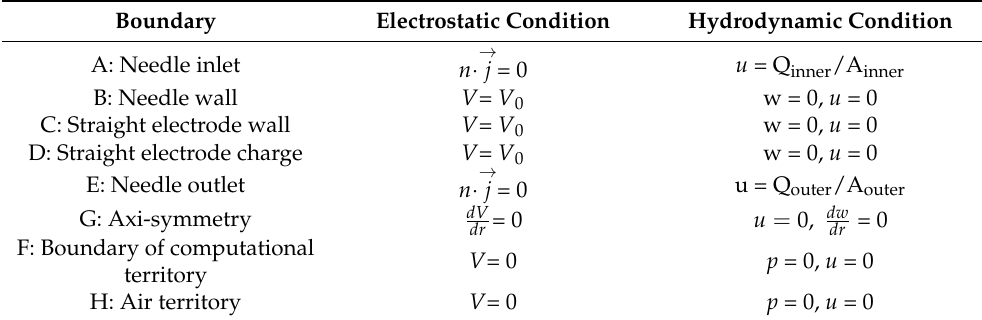
Table 2. Simulation boundary conditions of electrostatic field and flow